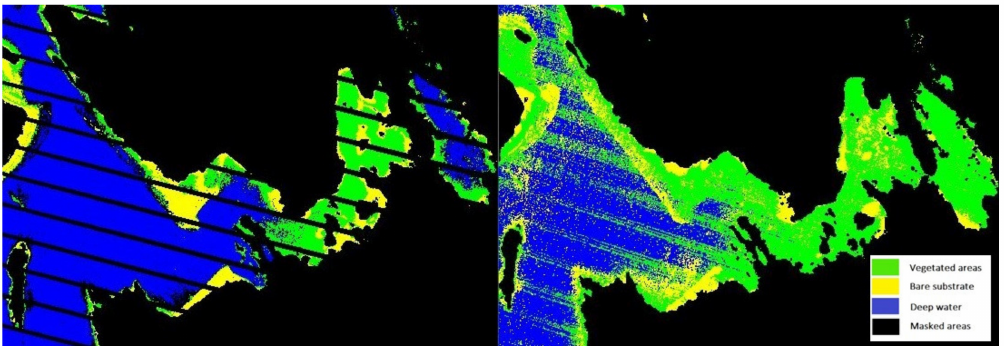
Figure 5. Landsat 7 image (on the left) from 10th May 2016 represents minimum vegetated area values in Haapsalu Bay. Landsat 5 image (on the right) from 27th July 1986 represents maximum vegetated area